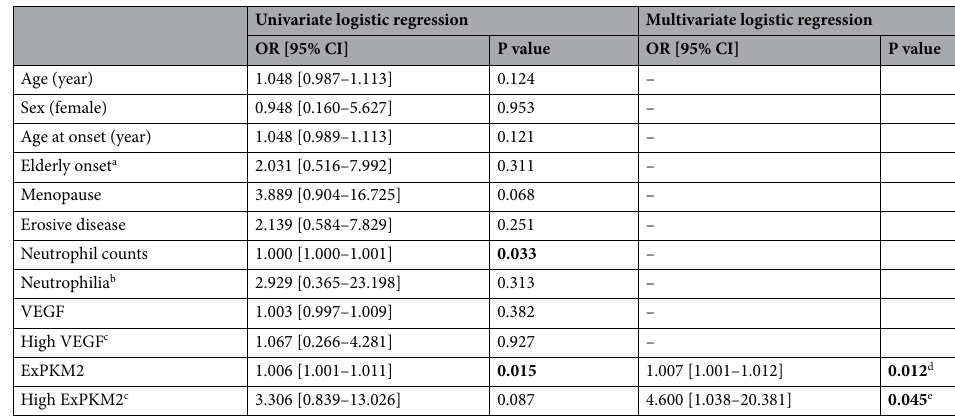
Table 1. Factor for radiographic progression in 47 early RA patients. OR odds ratio, CI confidence interval; a Defined as RA disease onset after the age of 60 years; b Absolute neutrophil counts > 7800/mm 3 ; c High exPKM2 or VEGF was defined as the highest quartiles of exPKM2 or VEGF levels in RA patients, respectively; d Continuous variables were entered without transformation or categorization; e Continuous variables were converted to binary categorical variables, except for age. p values <0.05 in univariate analysis in bold.